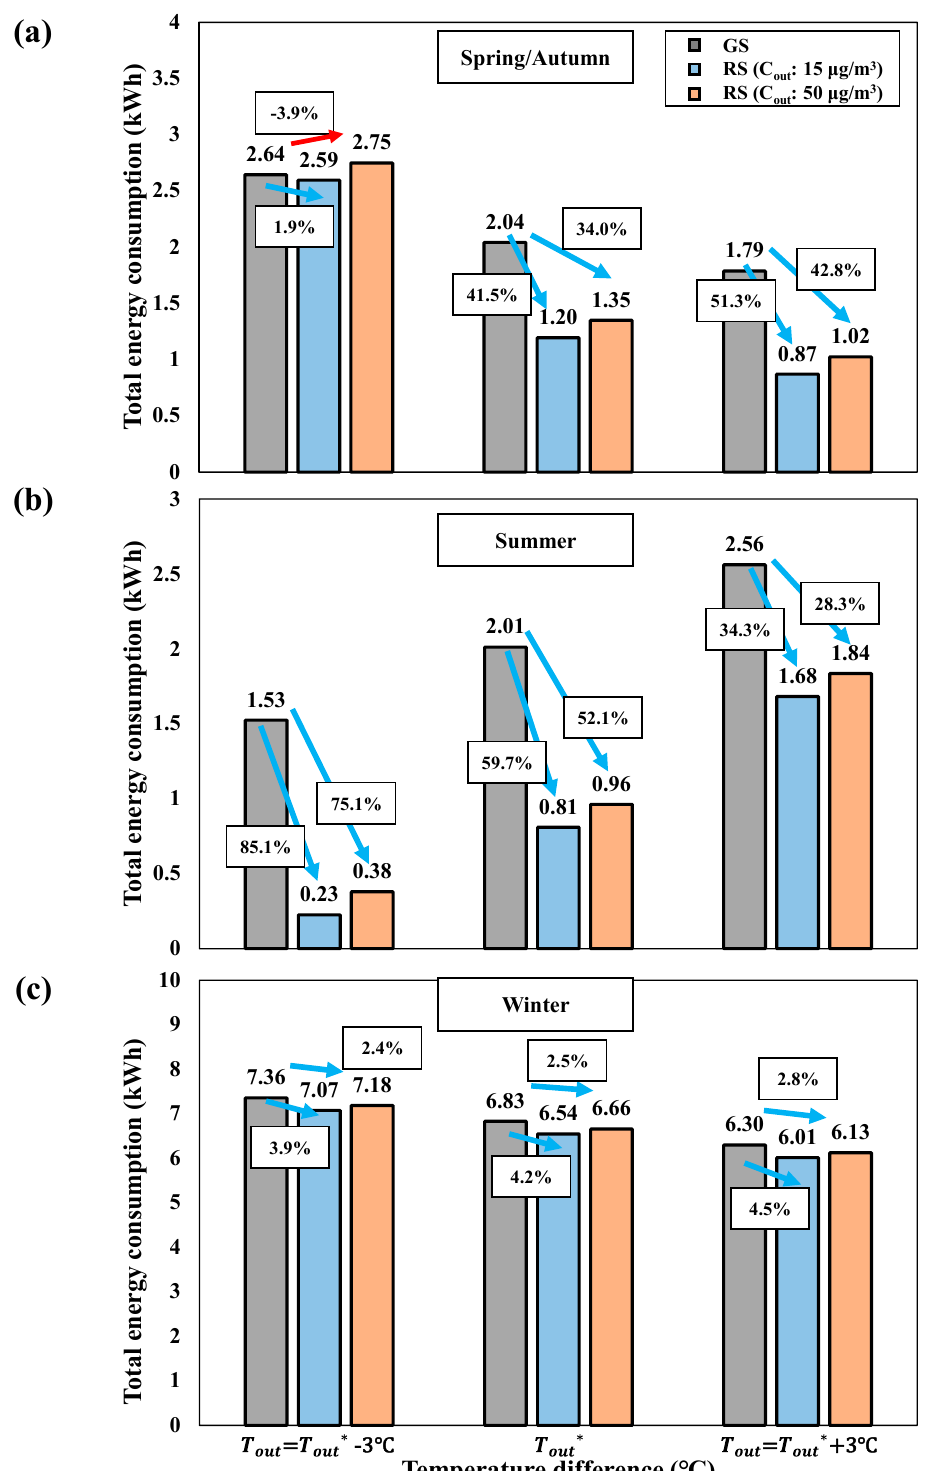
Figure 9. Total energy consumption of scenarios according to outdoor temperature in each season (GS: general scenario, RS: reduction scenario). ( a ) Spring/Autumn. ( b ) Summer. ( c ) Winter.